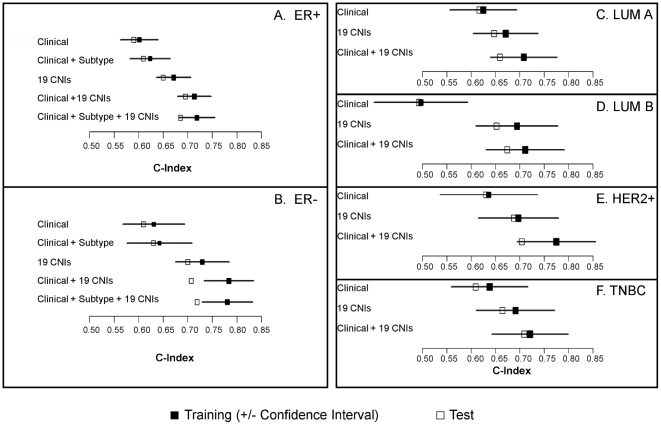
Concordance indices of prognostic models for probability of recurrence in training and test Set: (A) ER+, (B) ER-, (C) LUM A, (D) LUM B, (E) HER2+, and (F) TNBC.The closed square indicates the training set with the 95% confidence interval for the estimate, and the open square represents performance in the test set.